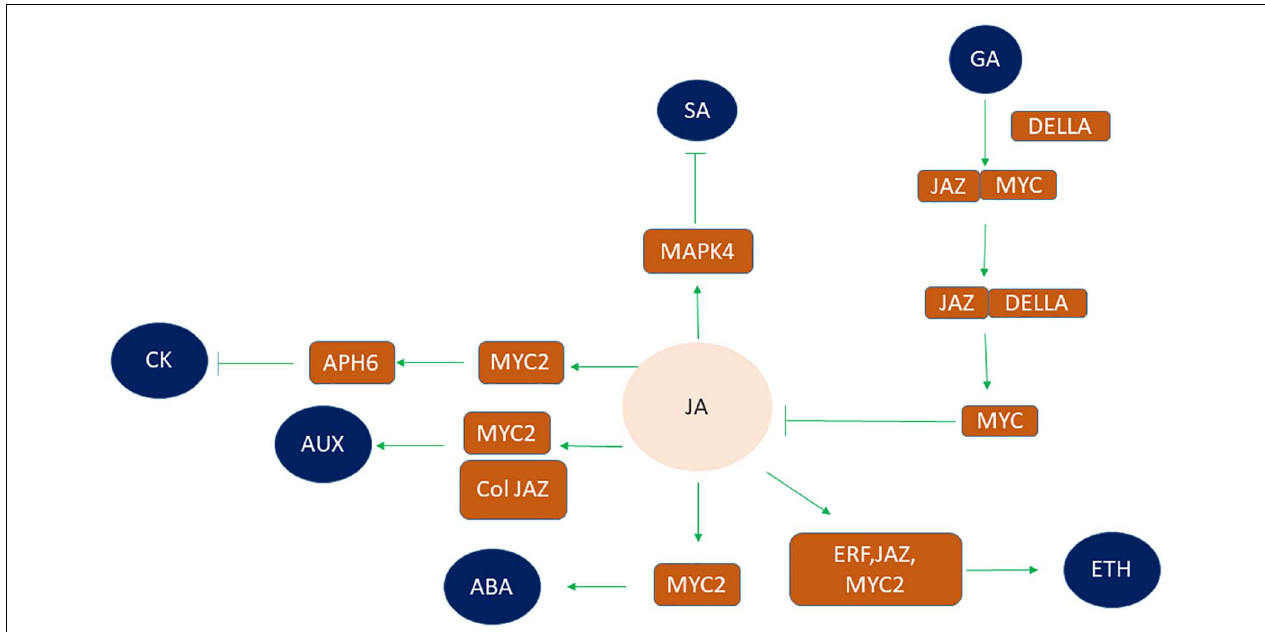
FIGURE 4 | Crosstalk between phytohormones with JA under abiotic stress conditions via different transcription factors. JA interacts with other phytohormones such as SA, ETH, ABA, GA, AUX, and CK in order to regulate plant abiotic stress. JA signaling inhibits SA by modulating mitogen activating protein kinase (MAPK4). Similarly, crosstalk of JA and ETH signaling pathway occurs through interaction of three TF’s viz ERF, JAZ, and MYC2 thereby regulating plant stress response. MYC2 also participates in crosstalk of JA and ABA signaling pathway. DELLA interacts with JAZ in absence of GA to release MYC thereby inhibiting JA biosynthesis and causing activation of MYC downstream genes. However, in the presence of GA, DELLA gets degraded so allowing JAZ-MYC interaction. COL, MYC2, and JAZ are the core components in the crosstalk of JA and AUX signaling pathways. JA mediated inhibition of CK signaling by MYC2 and AHP6 transcription factors. (AUX, auxin; SA, salicylic acid; ETH, ethylene; ABA, abscisic acid; GA, gibberellic acid; CK,